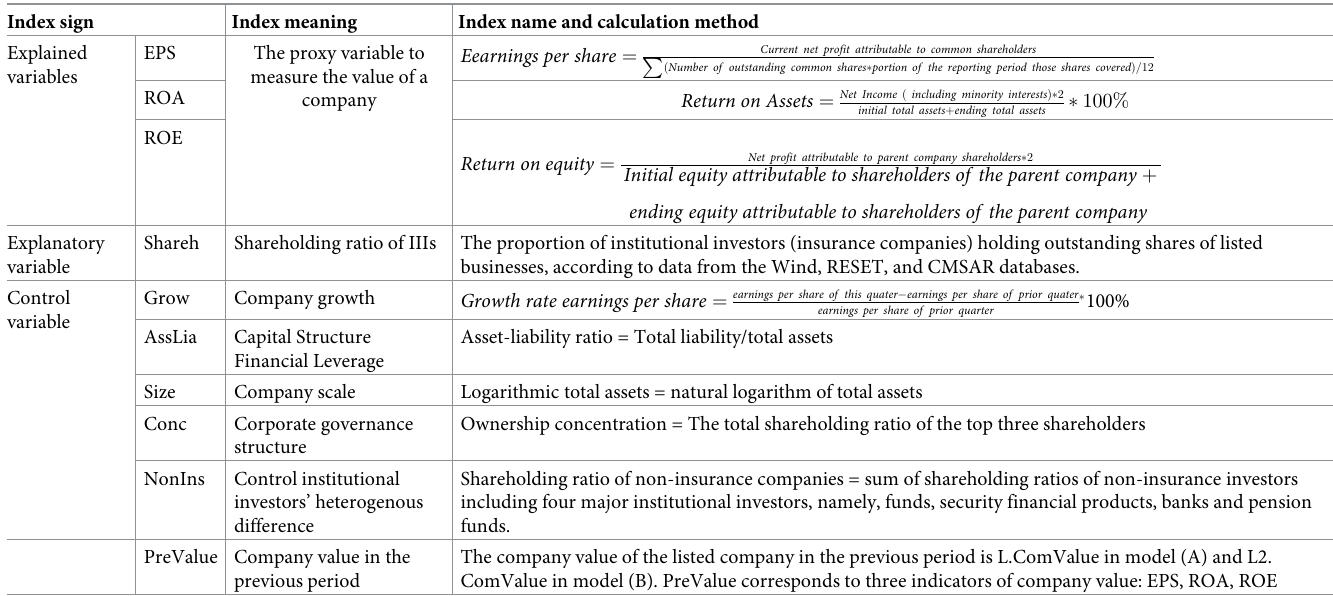
Table 1. Variables